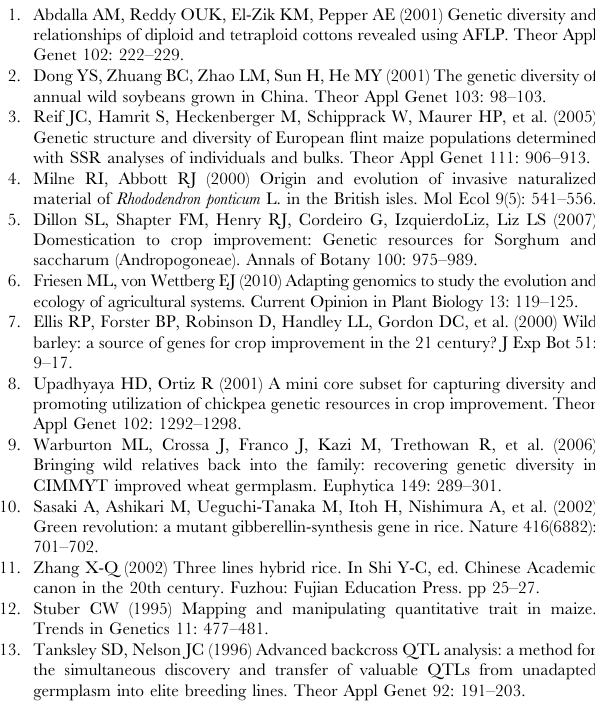
Table S2 Multi-QTL detection under various QTL heritabilities in the first simulation experiment (200 replicates).